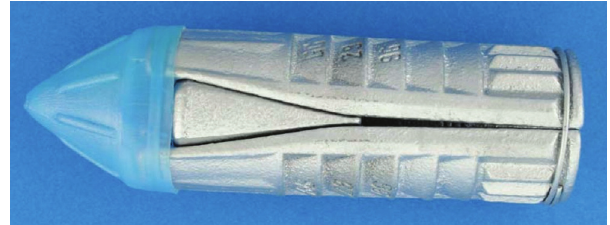
Fig. 1. KE-3W- head of the rock bolt [10]